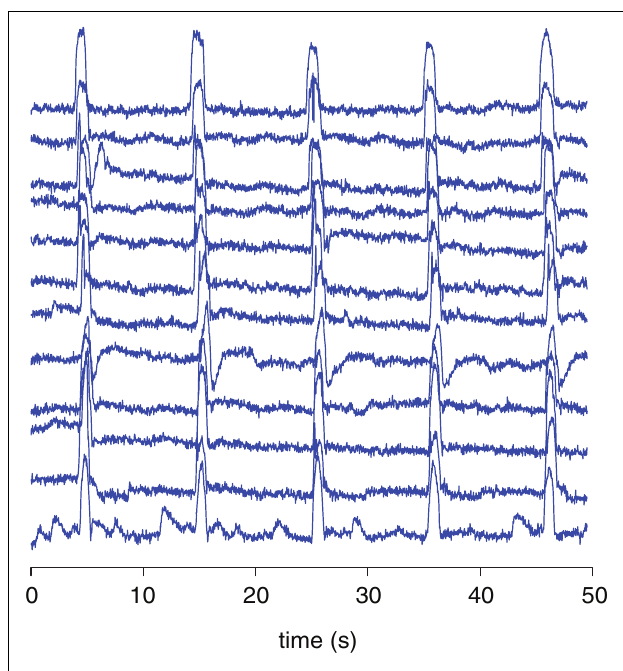
FIGURE 8 | Overlay of bend sensor data containing all 12 blocks of the /a/ condition recorded in one participant. The recordings are baseline-corrected (0–5 s prior to the beginning of the block).